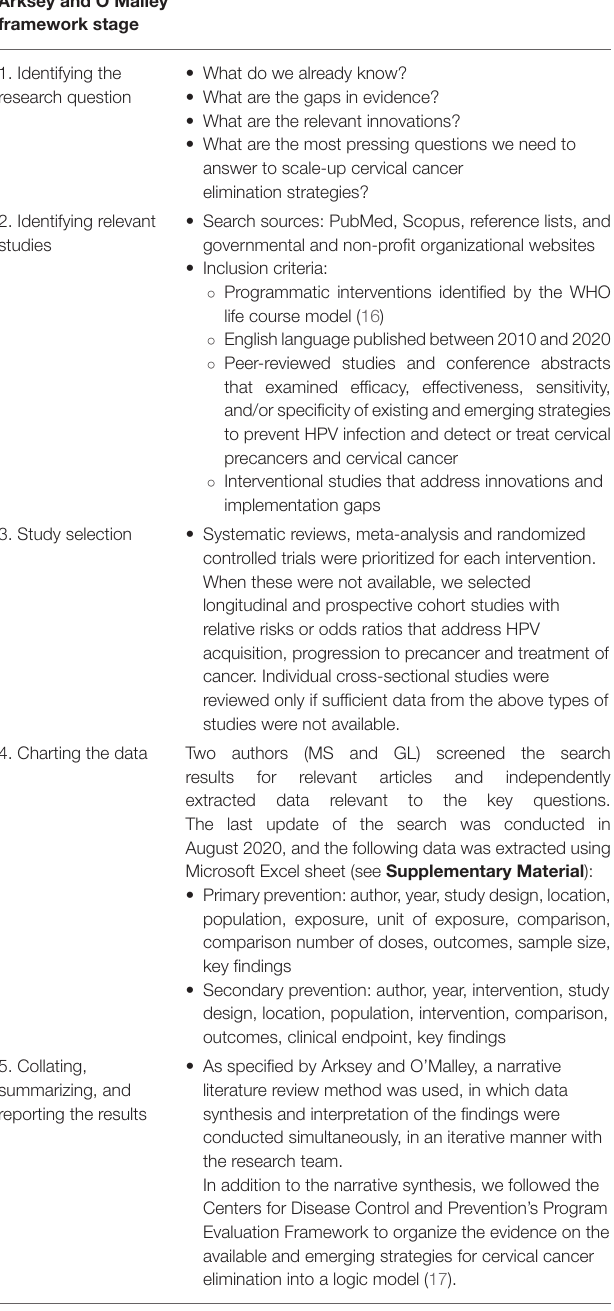
TABLE 2 | Scoping review framework and description of methods. Arksey and O’Malley framework